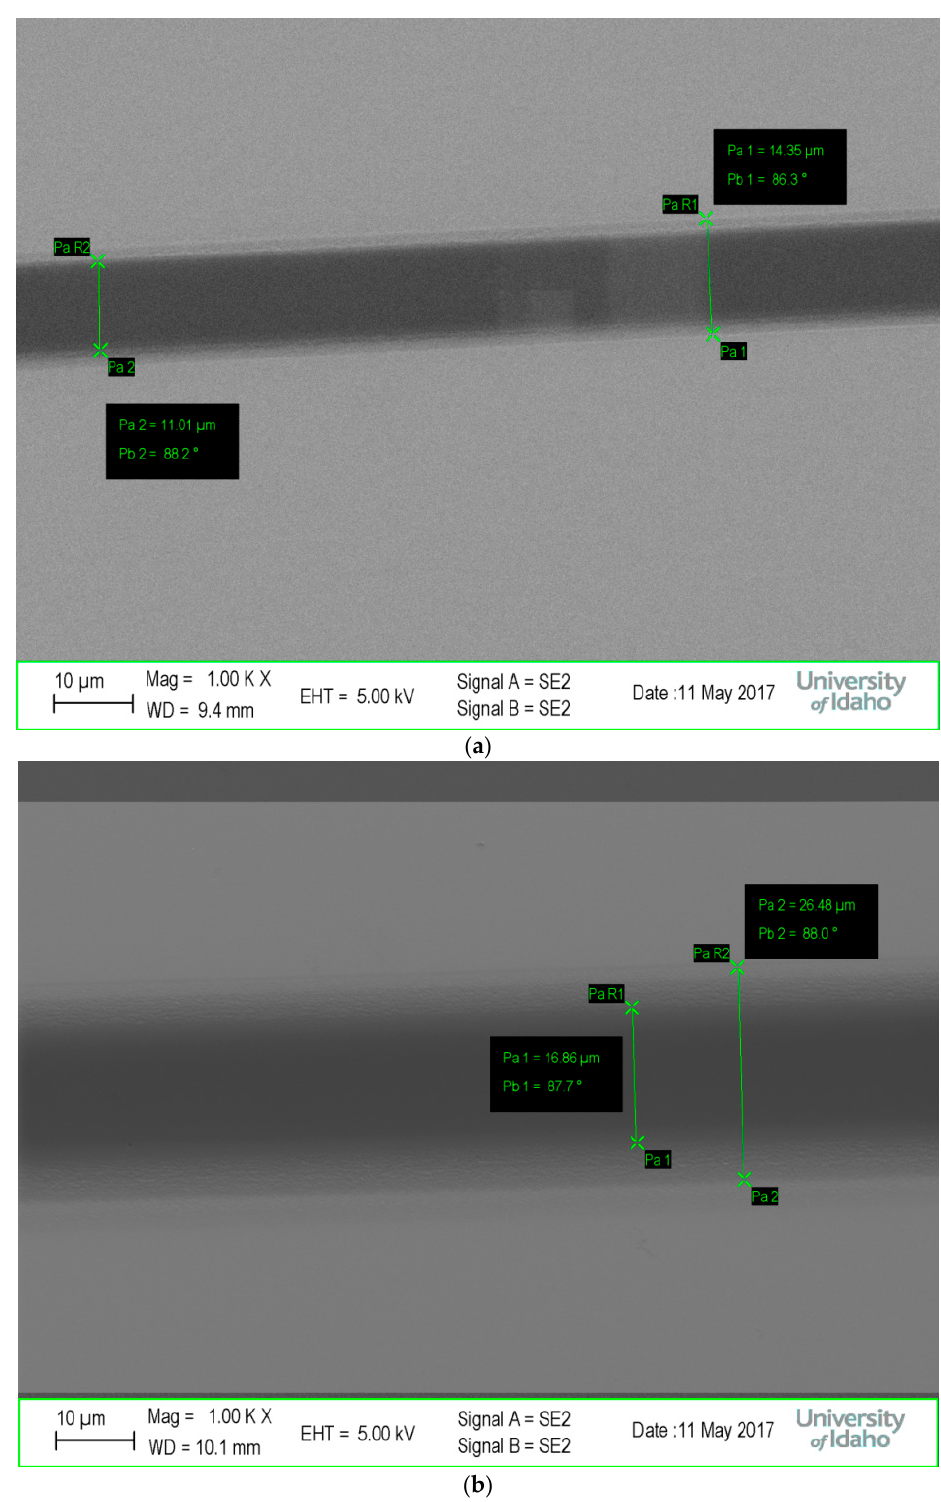
Figure 8. SEM imaging of ( a ) 50:50 NHNT and ( b ) 25:75 TPSTF examining LER.